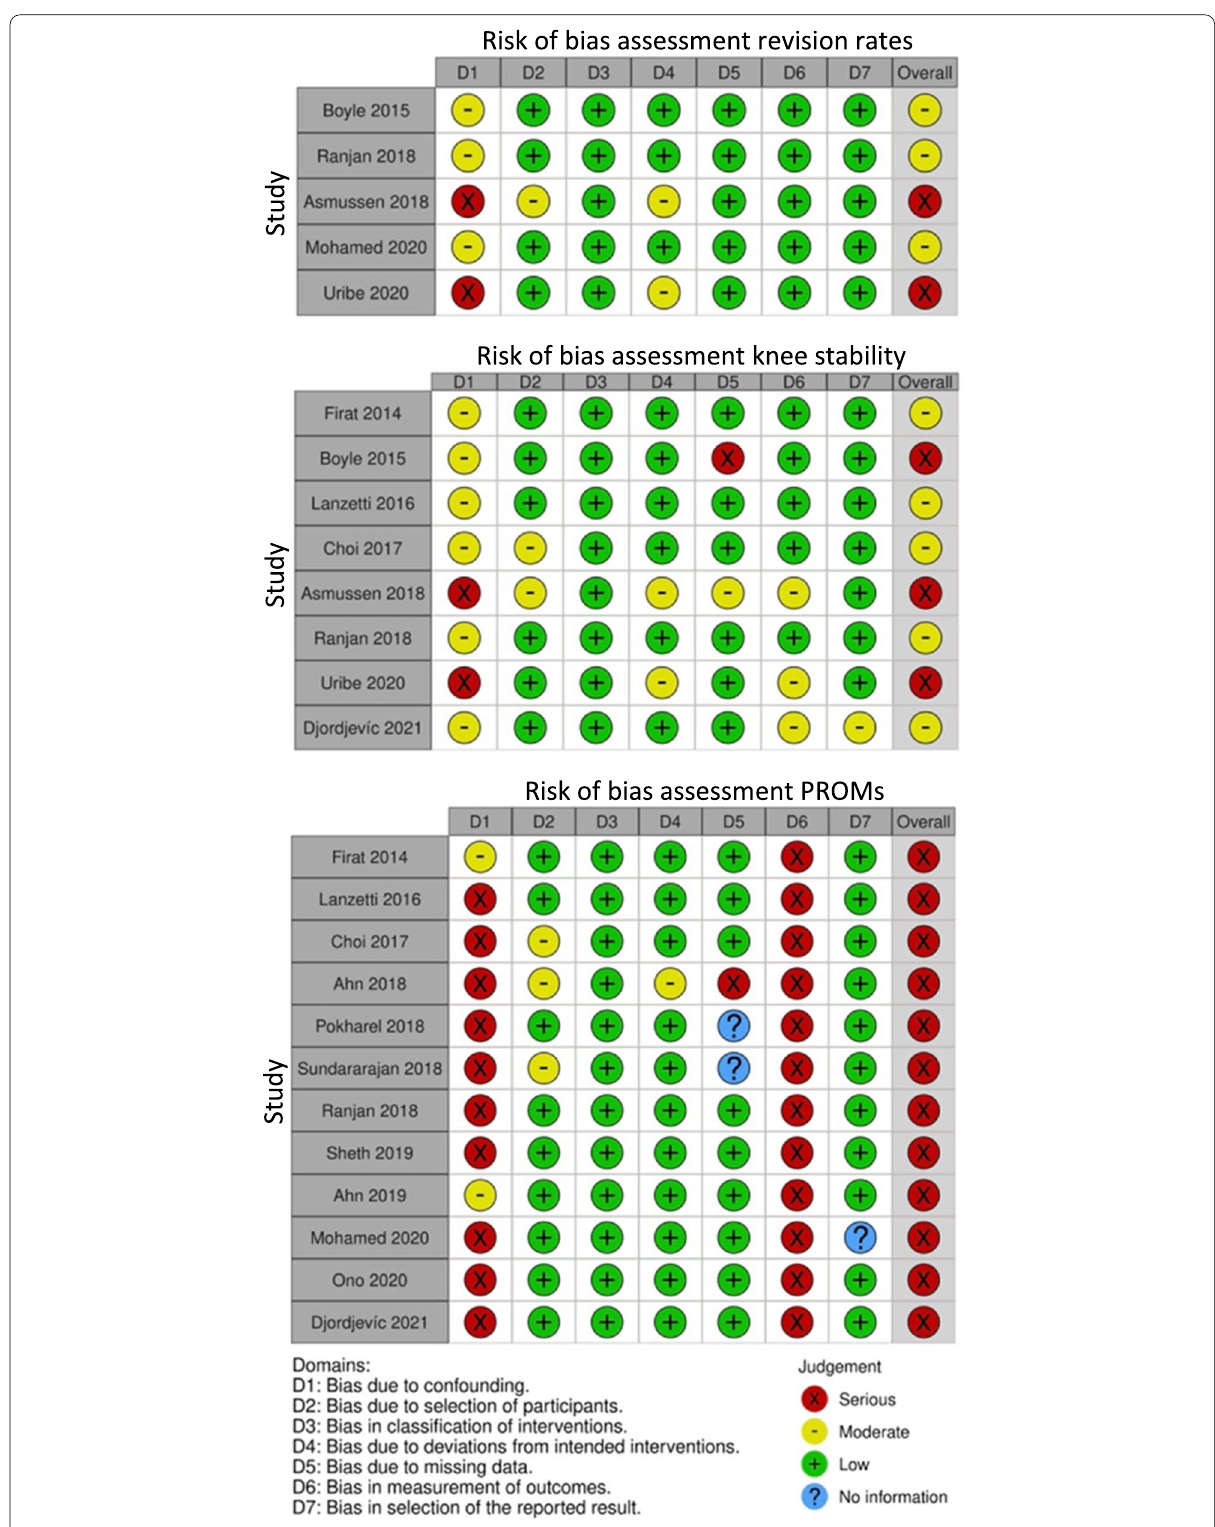
Fig. 3 Individual risk of bias assessment for all included